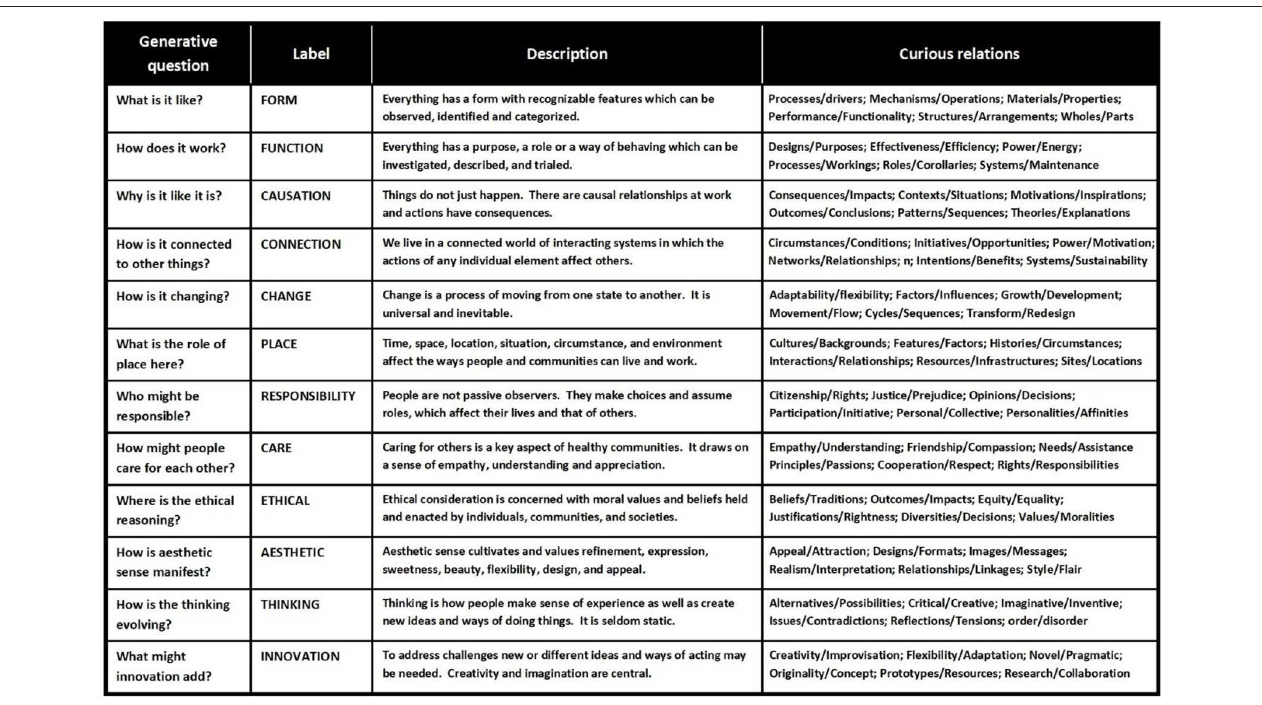
FIGURE 2 | Generic generative questions. Reproduced with permission from Freestone